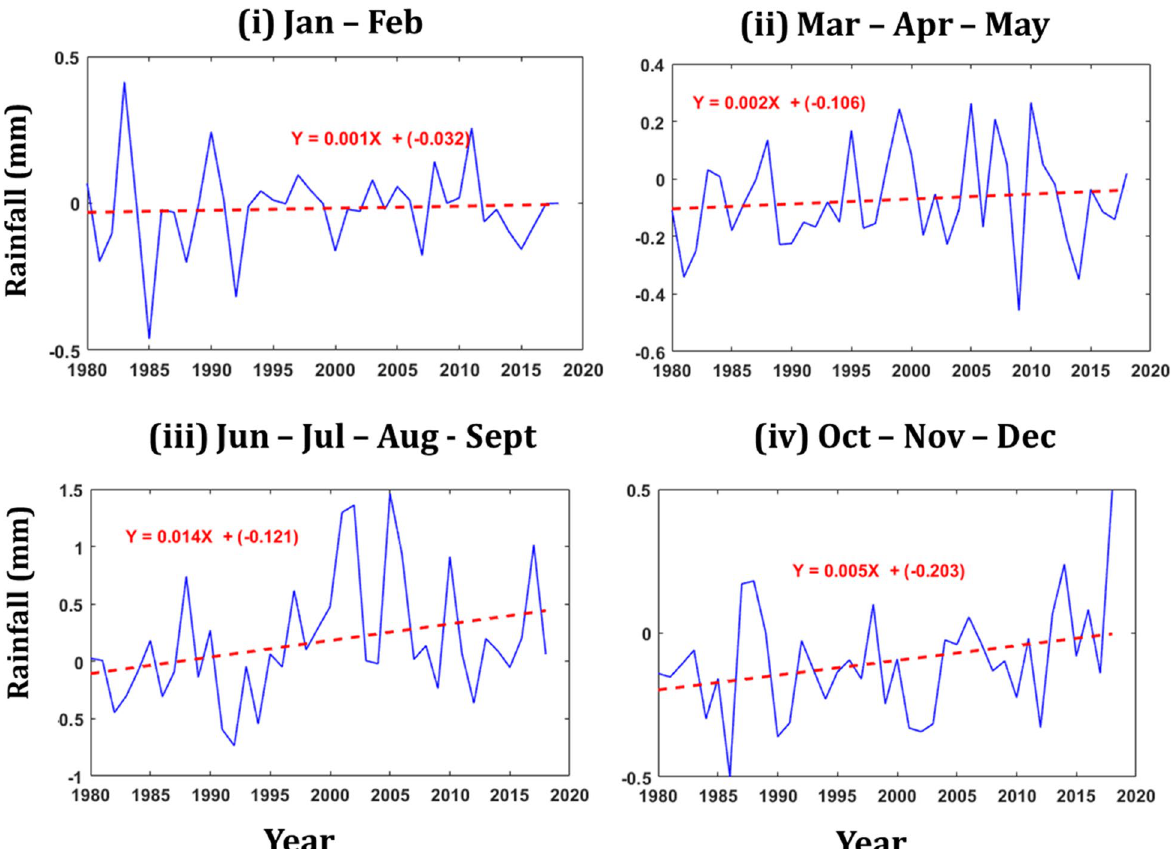
Fig. 9 Difference in rainfall over urban and per-urban grid-points during 1980–2019 for (i) Jan – Feb, (ii) Mar-Apr-May, (iii) Jun-Jul-Aug-Sept, and